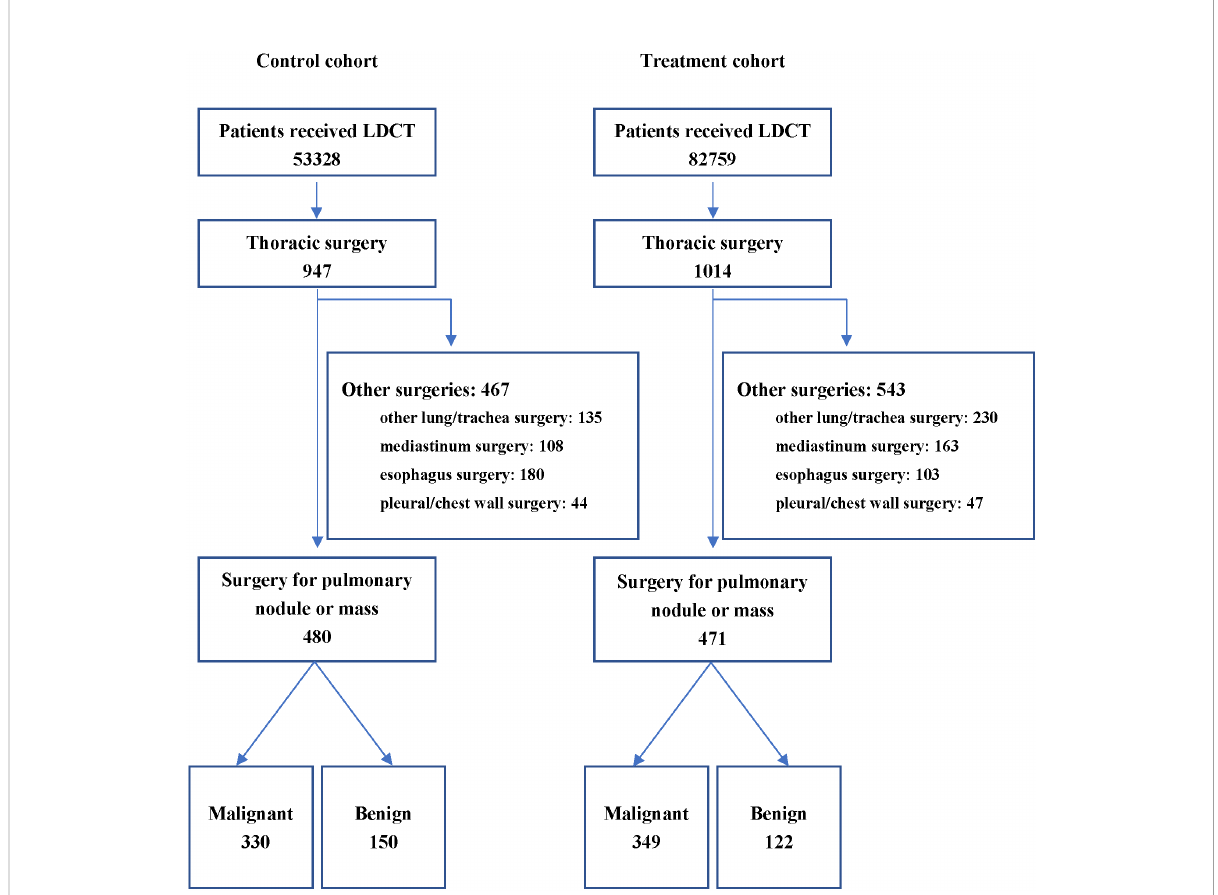
FIGURE 1 Flow Chart. The period from October 2019 to January 2020 was de fi ned as the control period, and the period from April 2020 to July 2020 was de fi ned as the treatment period. LDCT, low-dose computed